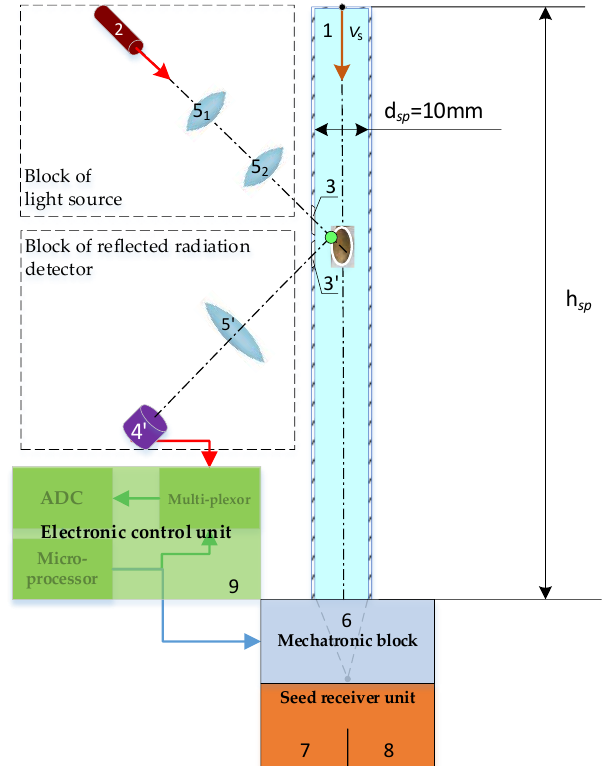
Figure 1. Structural-technological scheme of the grading system used in the study. 1 — seed pipe; 2 —light source; 3 and 3′— input recording window and windows for registering radiation, respectively; 4′— receiver for detecting diffusion reflected radiation; 5 1 and 5 2 — focusing lenses; 5′— focusing elements (fiber-optic Bragg gratings (I type) [35], Bragg mirrors (II type) [39], or a diffraction grating (III type) [41]); 6 — flap; 7 — conditioned seeds receiver; 8 — non-conditioned seeds receiver; 9 — electronic control unit; v s = 1.981 m s -1 ; h sp — height of seed pipeline; t h sp = 0.2 s. Adapted from